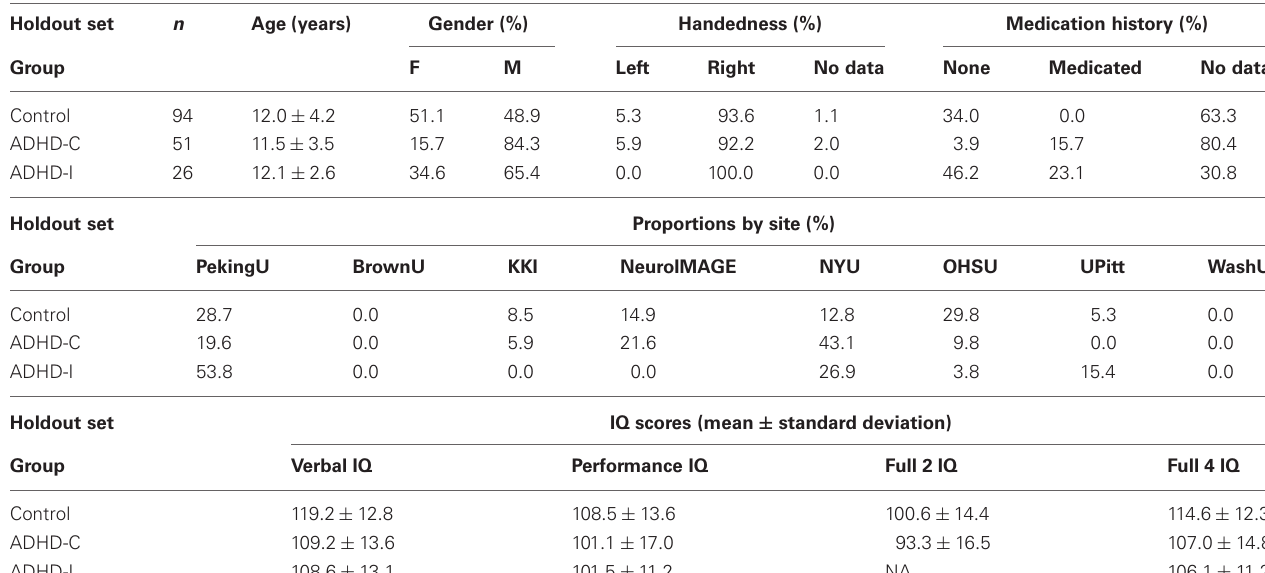
Table 2 | Details of Holdout Dataset